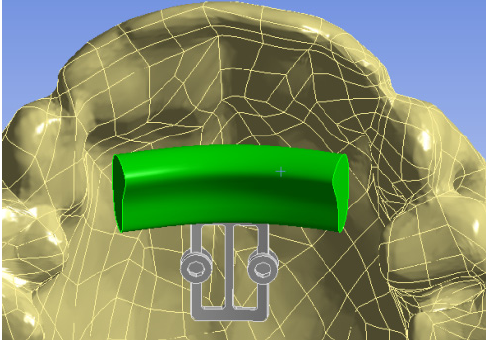
Figure 3. 3D jaw model with installed POD and bite plane.